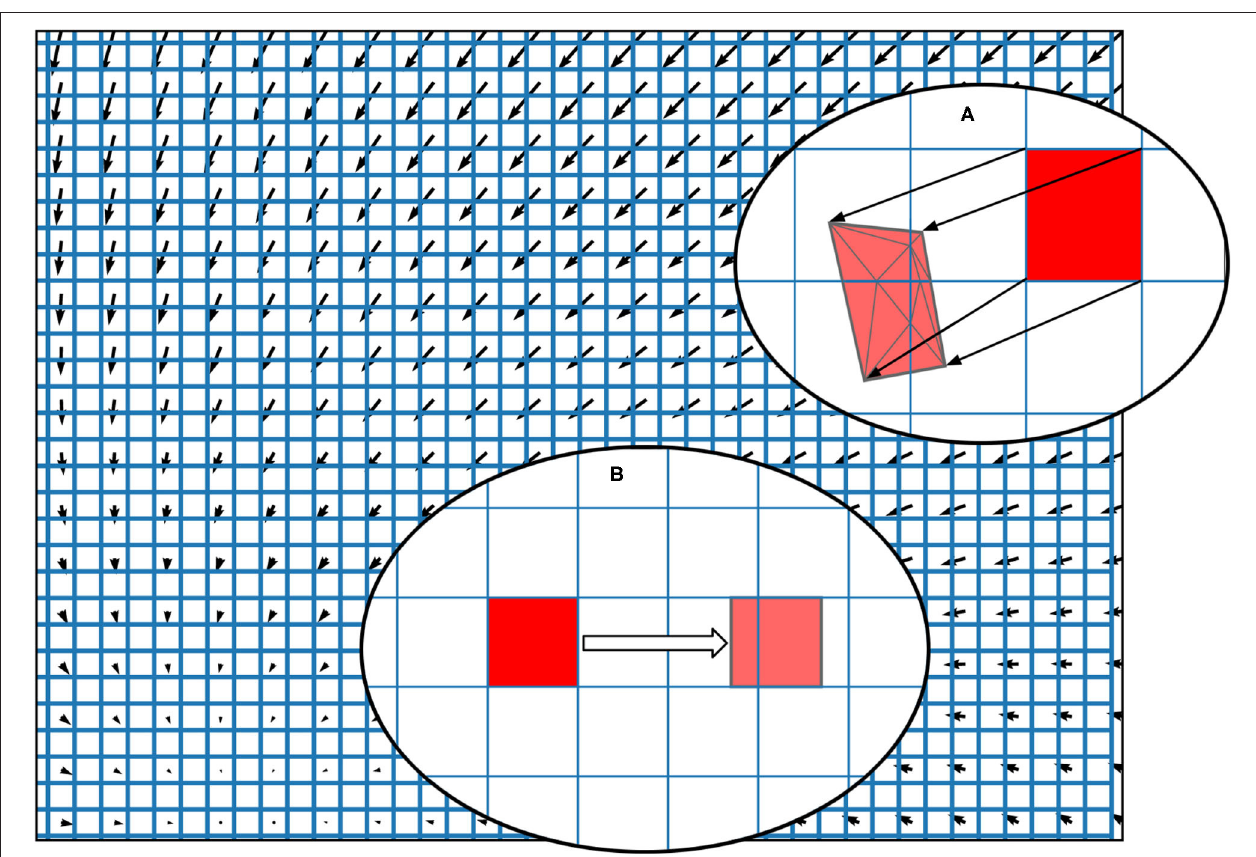
FIGURE 3 | The state space of a neuron model (shown here as a vector field) is discretised into a regular grid of cells. (A) The transition matrix for solving the deterministic dynamics of the population is generated by applying a single time step of the underlying neuron model to each vertex of each cell in the grid and calculating the proportion by area to each overlapping cell. Once the vertices of a grid cell have been translated, the resulting polygon is recursively triangulated according to intersections with the original grid. Once complete, all triangles can be assigned to a cell and the area proportions can be summed. (B) For a single incoming spike (with constant efficacy), all cells are translated by the same amount and therefore have the same resulting transition which can be used to solve the Poisson master equation. In fact, the transition will always involve at most two target cells and the proportions can be calculated knowing only the grid cell width and the